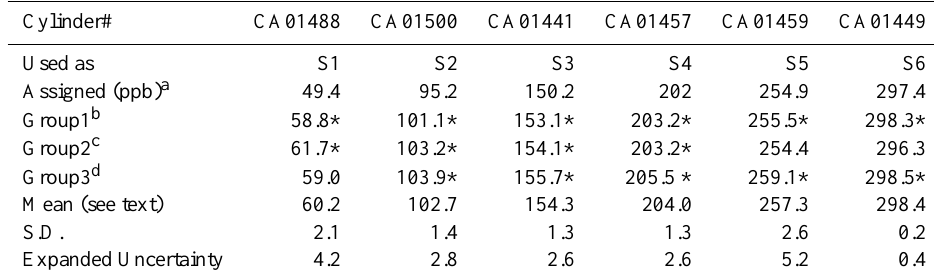
Table 1. S1–S6 lab primary standards cylinders revision for CO mixing ratios.